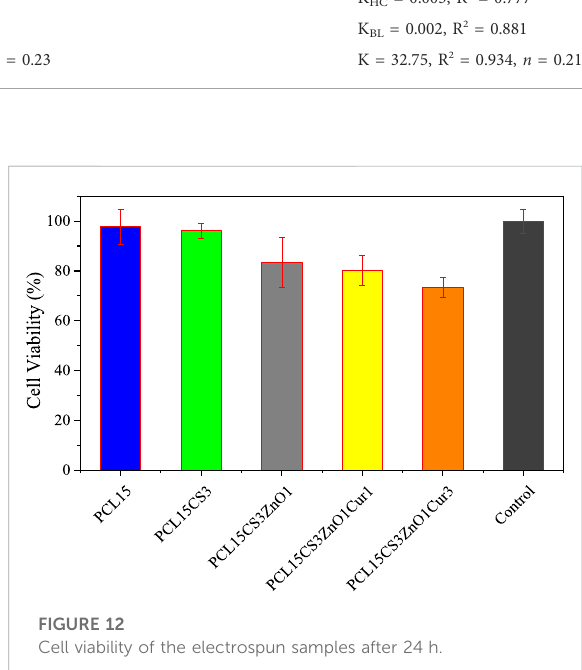
FIGURE 12 Cell viability of the electrospun samples after 24